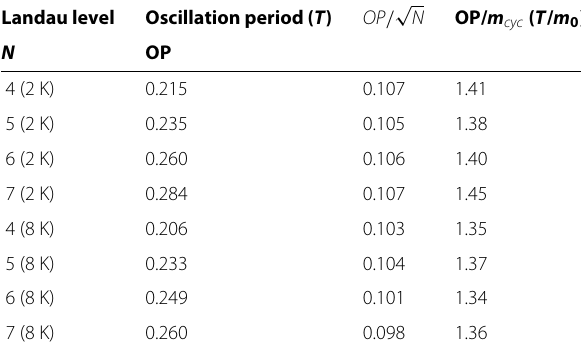
Table 1 List of the extracted oscillation period at different Landau levels and temperatures Landau level